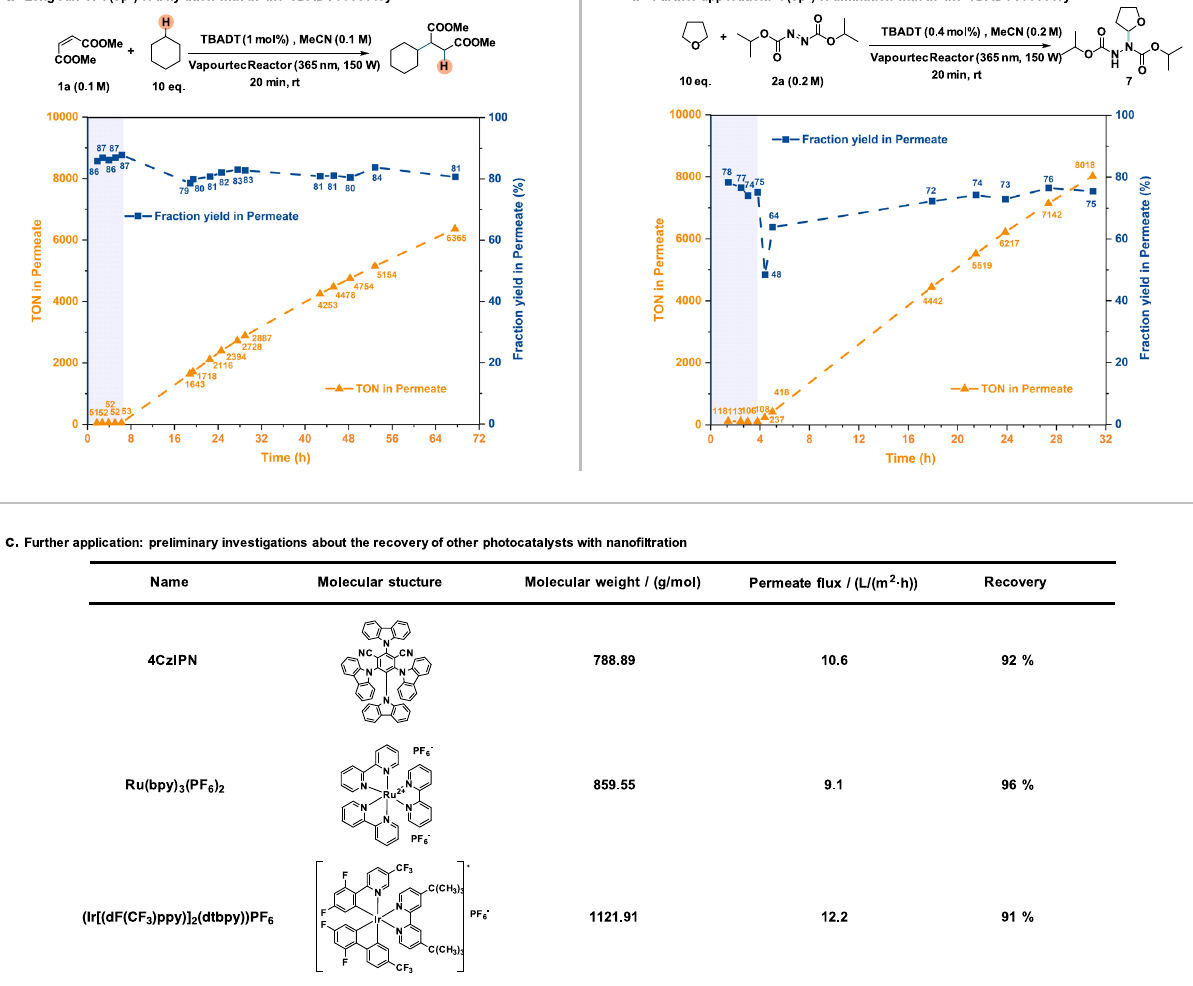
Fig. 5 | Practicalityinvestigations ofthe nano fi ltration process. a Fraction yield and TON in permeate of a 60-h run of C(sp 3 ) – H alkylation executed with in-line TBADT recovery. The equilibration phase of the experiment is reported with a shadedbackground. b FractionyieldandTONinpermeateofa27-hrunofC(sp 3 ) – H